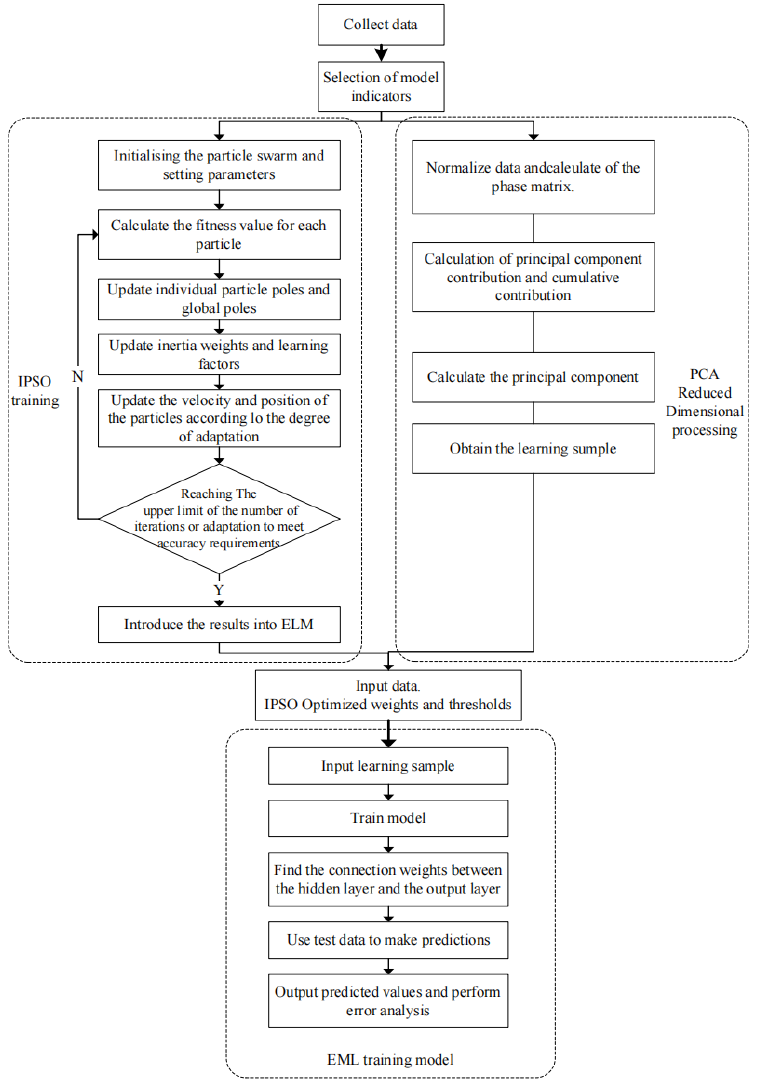
Figure 4. Flow chart of PCA-IPSO-ELM model.